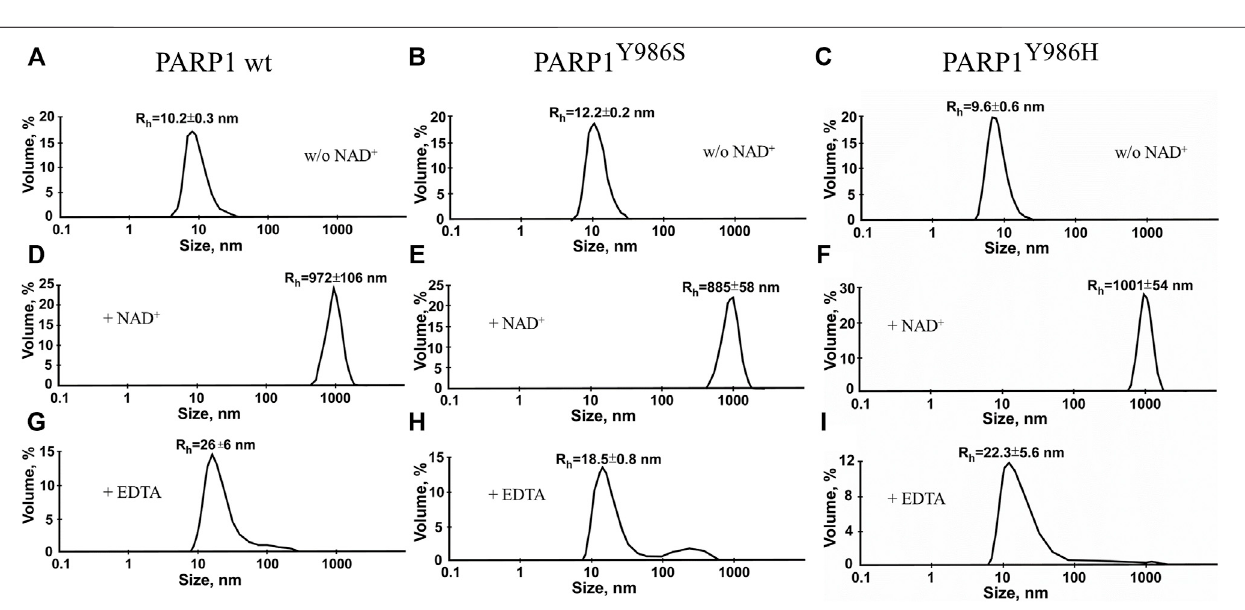
Frontiers in Cell and Developmental Biology |